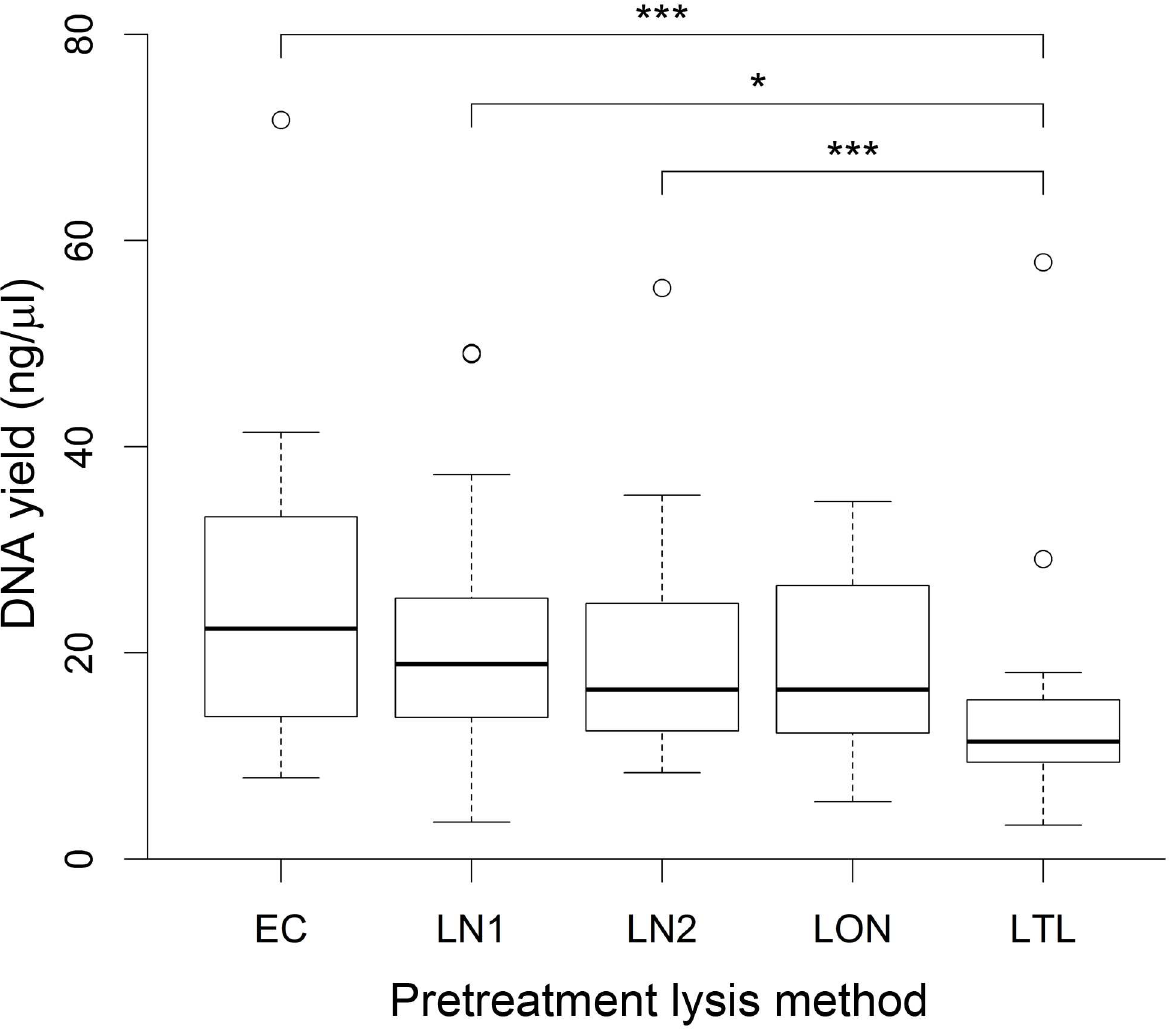
Fig 2. Box and whiskerplotshowingDNA yieldobtainedby each pretreatment lysis method. Boxes extend fromthe lower quartiles to the upperquartileswith medianvalues indicated by the line withineach box. Whiskers represent maximum and minimum values, excluding any outliers(values indicated by circles which lie outside1.5 times the interquartilerange).Significant differences betweenmethodsare starred( * P < 0.05; ** P (cid:20) 0.01; *** P (cid:20)